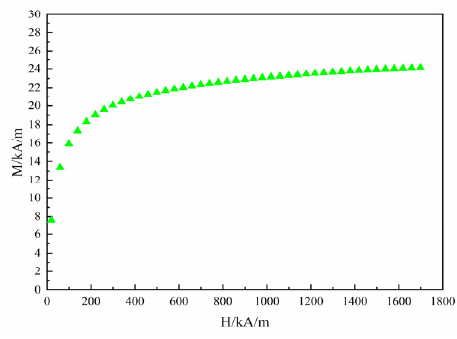
Figure 8. The magnetization curve of the magnetic fluid.